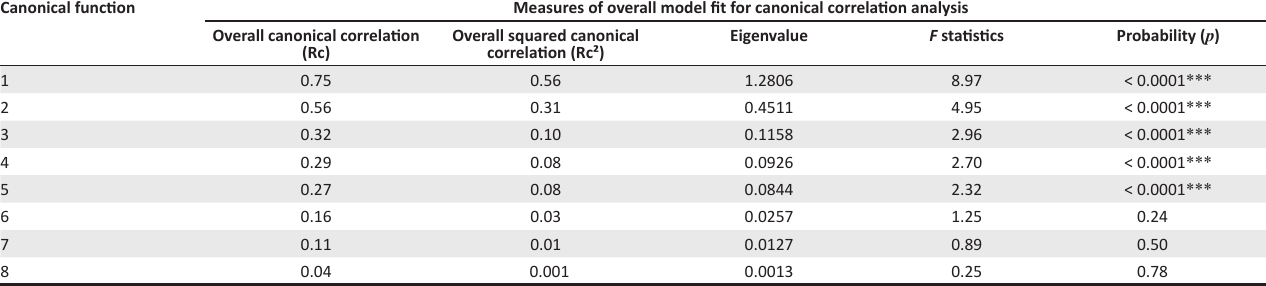
TABLE 3a: Canonical correlation analysis ‒ Overall model fit statistics . Canonical function